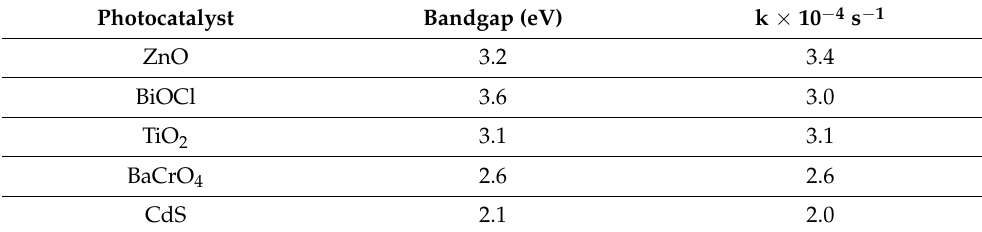
Table 1. Effects of other